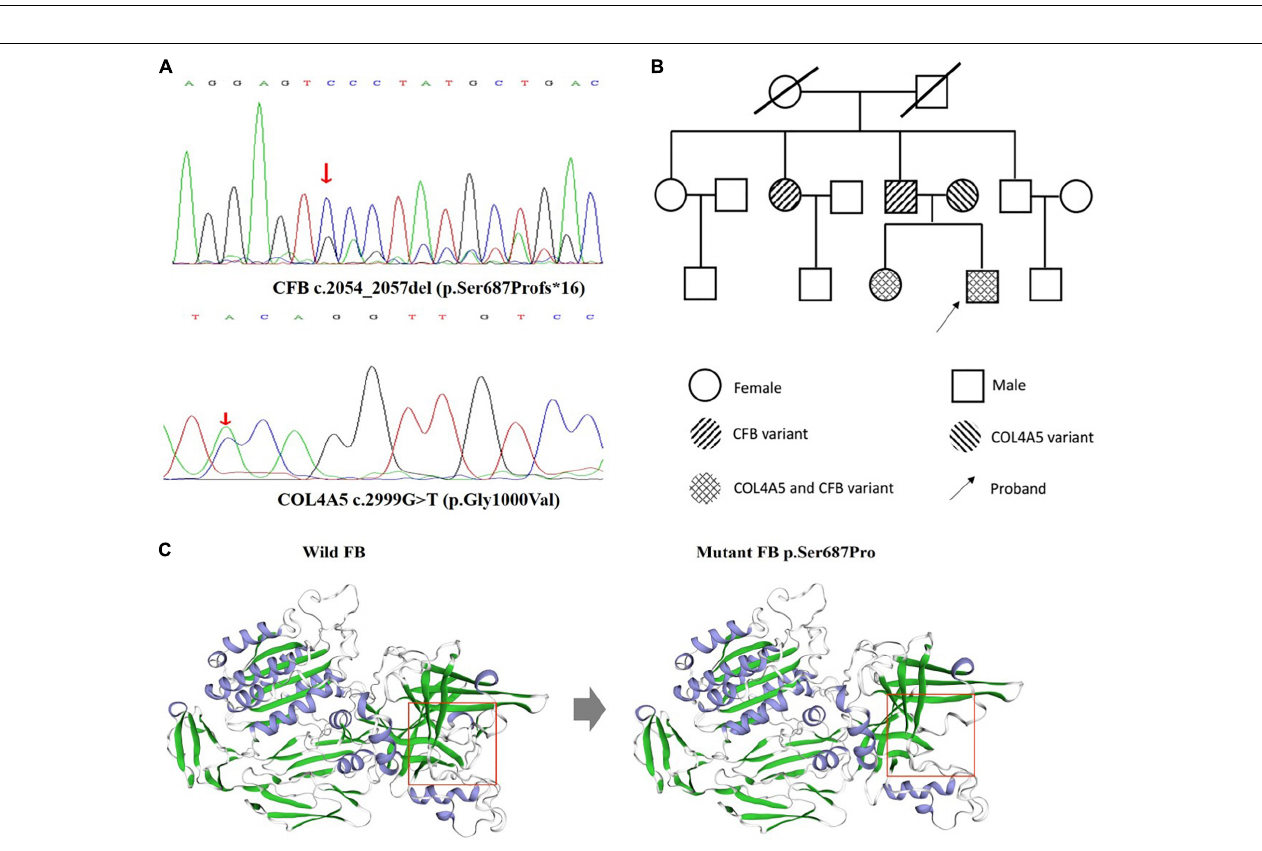
FIGURE 2 | DNA analysis of the patient and family members and structural evaluation of mutant FB p.Ser687Pro. (A) Direct sequencing of patient genomic DNA shows the c.2054_2057del (p.Ser687Profs*16) novel genetic variant in exon 16 of the CFB gene, c.2999G > T (p.Gly1000Val) in exon 34 of the COL4A5 gene. (B) The pedigrees of the family with digenic inheritance. (C) Visualization of the mutant FB. The figure was prepared using swiss-model. Pr, proteinuria; He, hematuria. Red arrow means the position of mutation. Red square means the impact of the frameshift mutation on splice site changes and protein features.